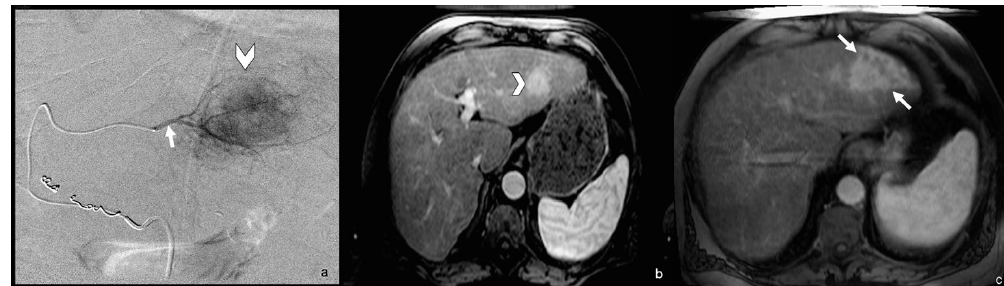
Figure 2. Radiation segmentectomy of HCC. ( a ) Angiogram of segmental tumor-supplying vessel (arrow) and tumor (arrowhead). ( b ) Pre-treatment MRI demonstrating arterial-enhancing tumor (arrowhead). ( c ) Post-treatment MRI showing radiation-induced changes in tumor-containing segment (arrows). Reproduced with permission from [43].